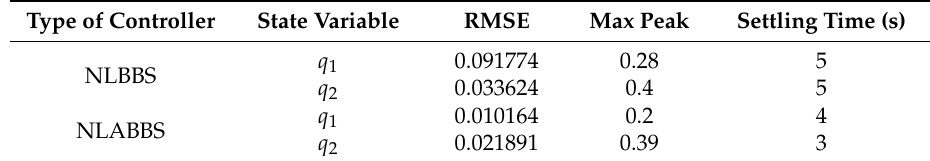
Figure 7. Dynamic Responses of different state variables and control signals for the systems based on the adaptive and conventional block-backstepping controllers: ( a ) cart displacement; ( b ) cart linear velocity; ( c ) ball angular position; ( d ) ball angular velocity; ( e ) control signals; ( f ) error between the actual and desired positions of the cart. Table 5. Tracking performance of the ball–arc system based on the controllers. Table 5. Tracking performance of the ball–arc system based on the controllers.